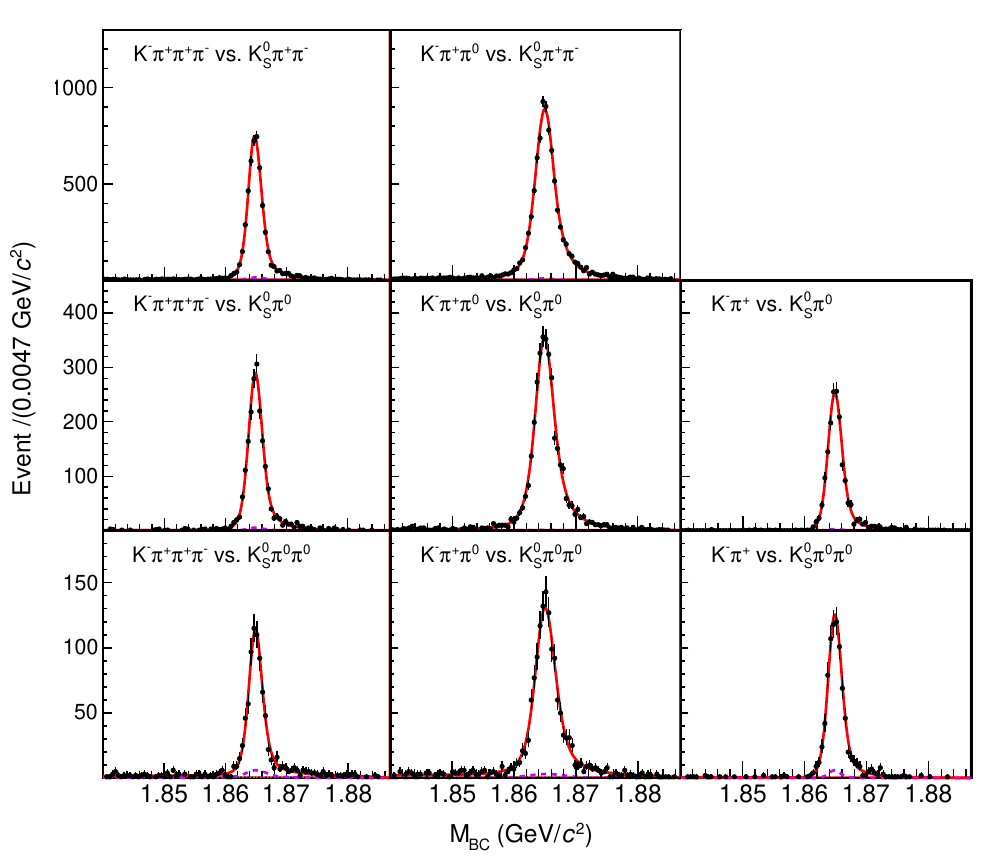
Figure 12 . M BC distributions for decays tagged by the modes D → K 0 D → K 0 π 0 π 0 . The points with error bars are data; the red line indicates the total fit; the dashed S purple line shows the peaking-background contributions; the combinatorial-background contribution is at too low a level to be